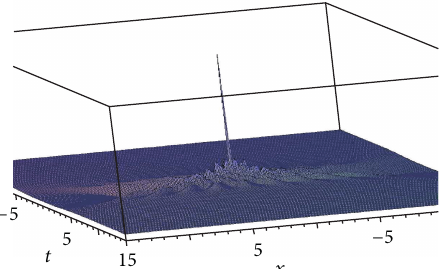
Figure 1: Solution of NLS, 𝑁 = 9 , 𝑎 1 = 0 , 𝑏 1 = 0 .